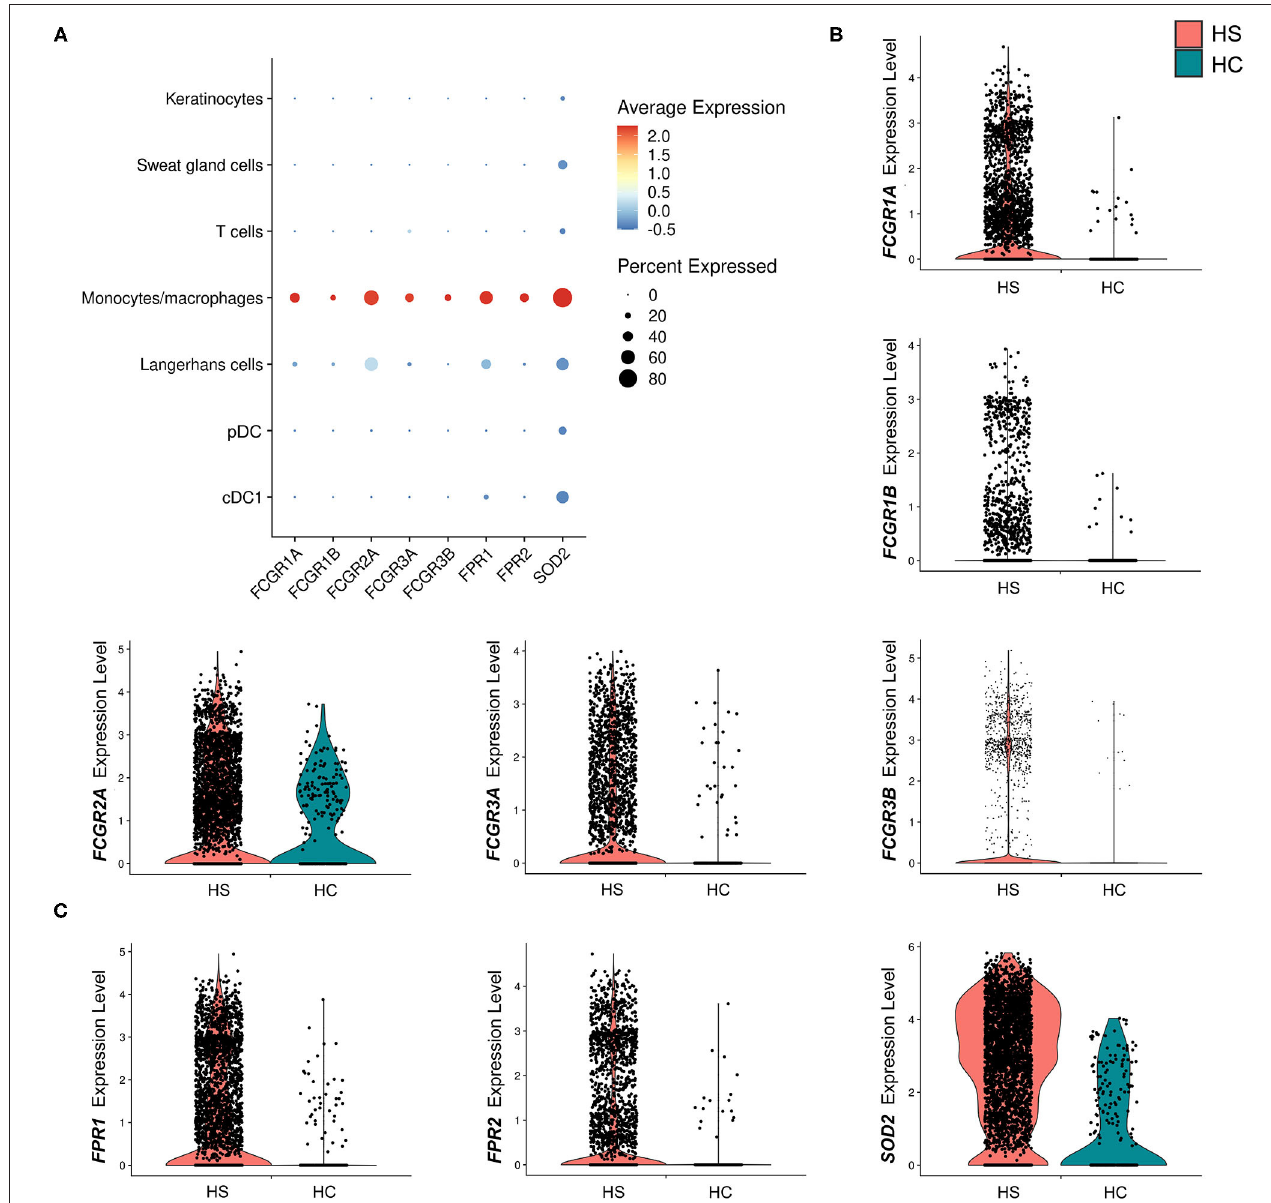
FIGURE 5 | Macrophages in HS lesions show upregulation of markers associated with Fc signaling and metabolic activity. (A) Dot plot showing the percent expressed and average expression of genes related to phagocytosis and metabolic activity between key cellular populations in HS skin. (B) Violin plots for the monocyte/macrophage cluster of genes related to Fc signaling. (C) Violin plots for the monocyte/macrophage cluster of genes related to respiratory burst. cDC, conventional dendritic cell; HC, healthy control; pDC, plasmacytoid dendritic cell.